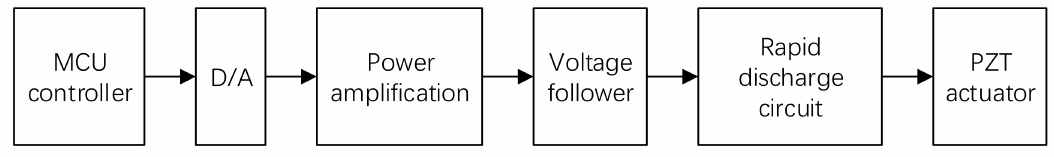
Figure 2. PZT driving power